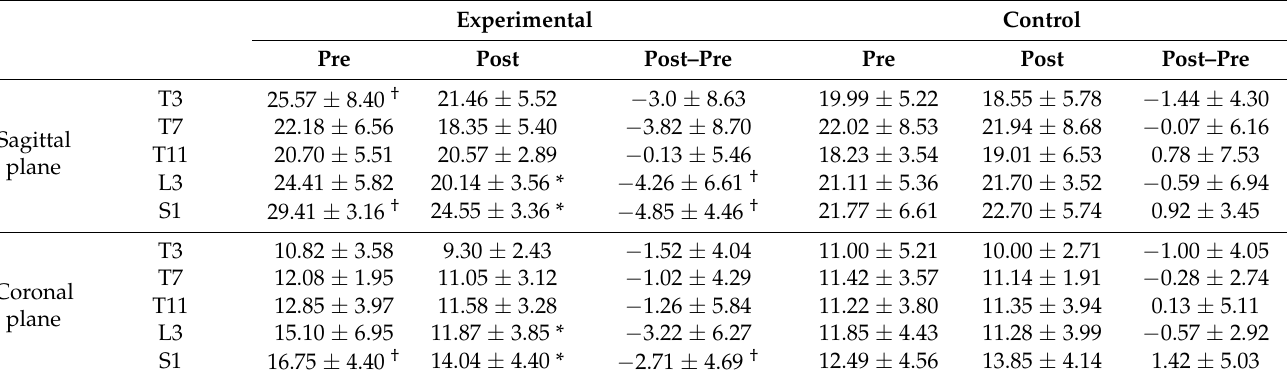
Table 5. Comparison of sway distance in sagittal and coronal plane (unit: cm).